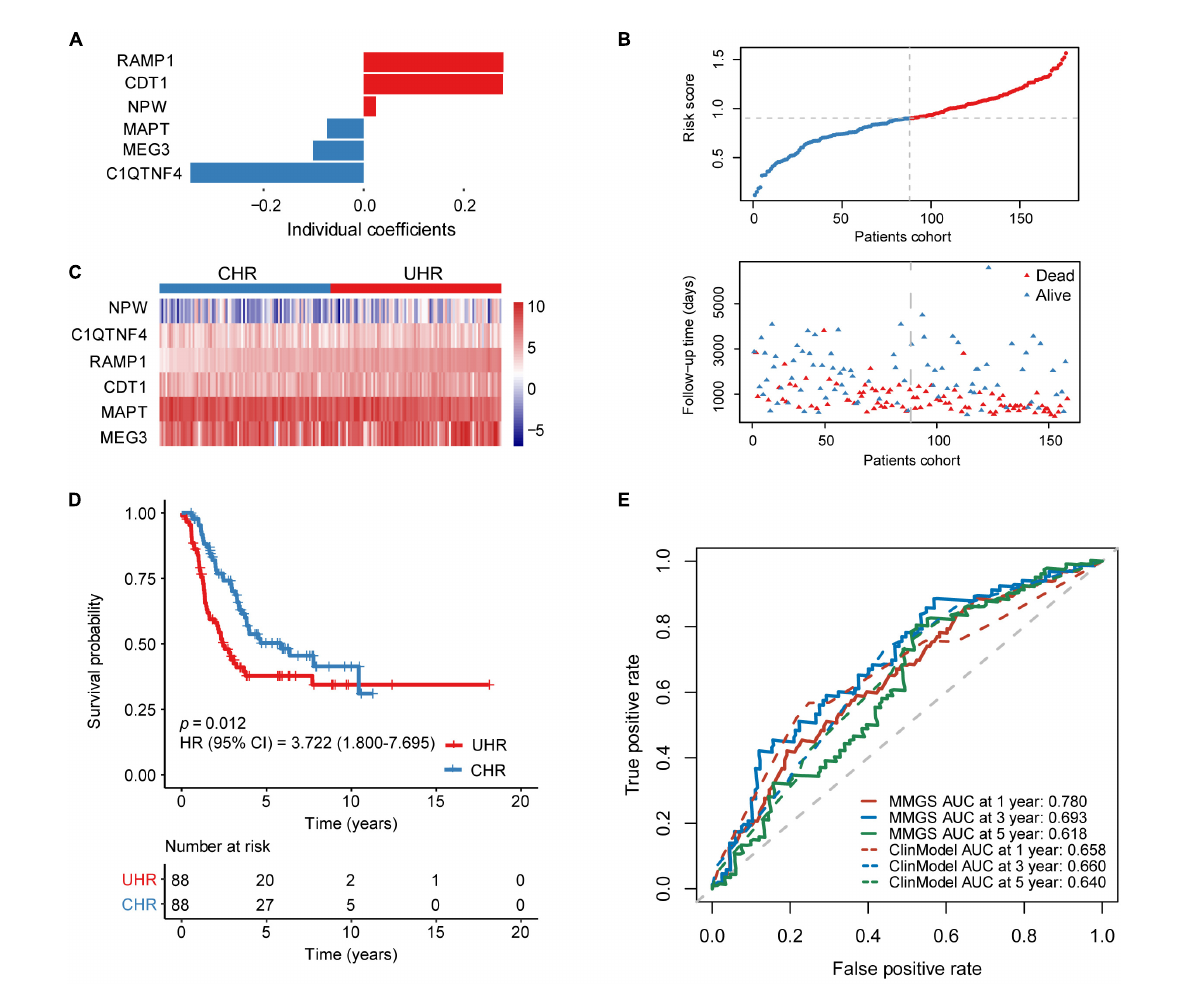
FIGURE2 Establishment of MMGS in the SEQC HRNB cohort. (A) The coefficients of the identified six malignant cell marker genes. (B) The distribution of risk score and survival status. (C) The expression characteristics of the identified six malignant cell marker genes. (D) KM curves of OS between the UHR and CHR groups. (E) ROC curves of MMGS model (solid lines) and clinical model (dot lines) to predict the 1-, 3-, and 5-year OS. ClinModel, clinical model; HR, hazard ratio; CI, confidence interval.